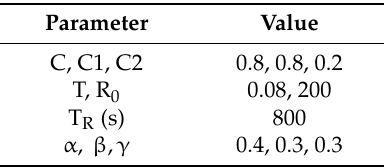
Table 2. Optimal parameter values for